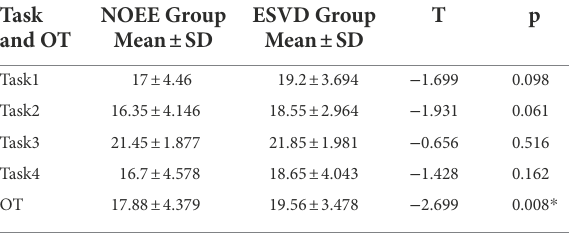
TABLE 6 Independent sample t -test for Task1/2/3/4 and overall Task between NOEE and ESVD groups. Task and OT